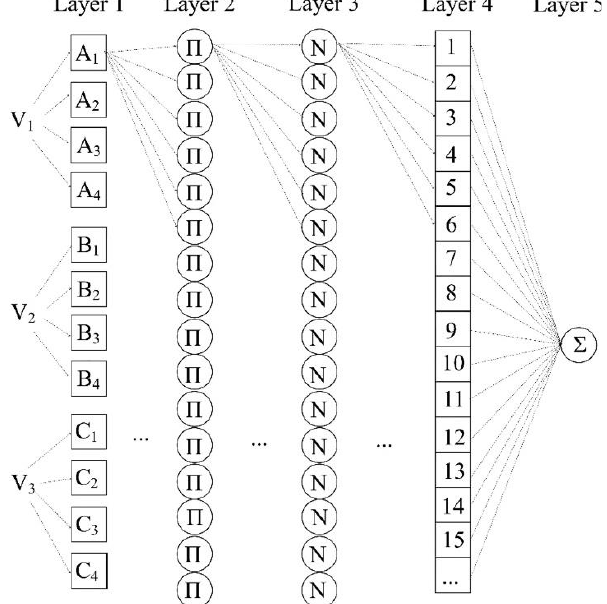
(cid:80) is the sum